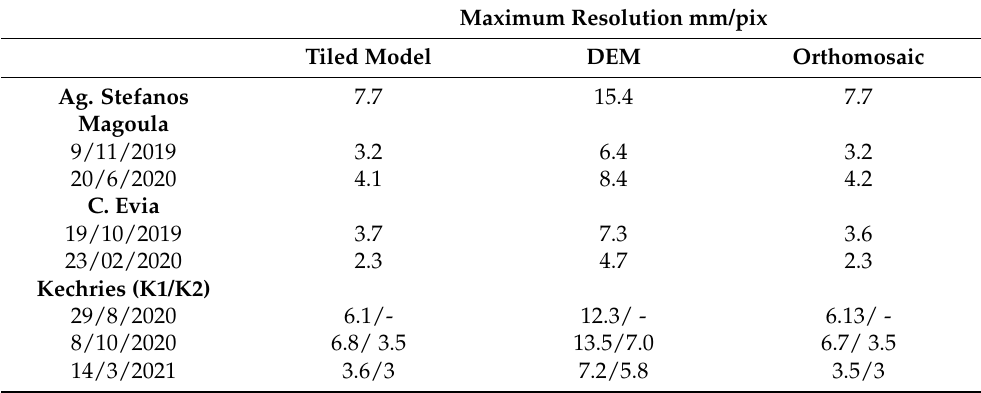
Table 4. SfM-derived models